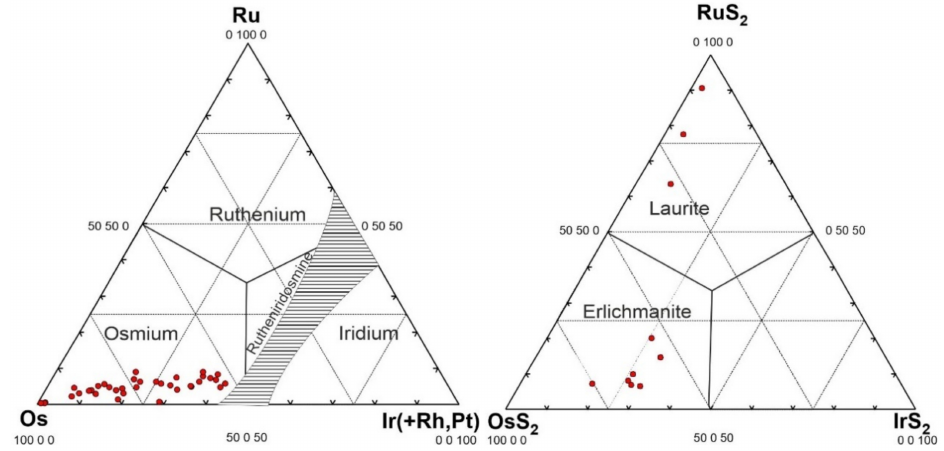
Figure 7. Ternary plots depicting the compositions of the platinum group